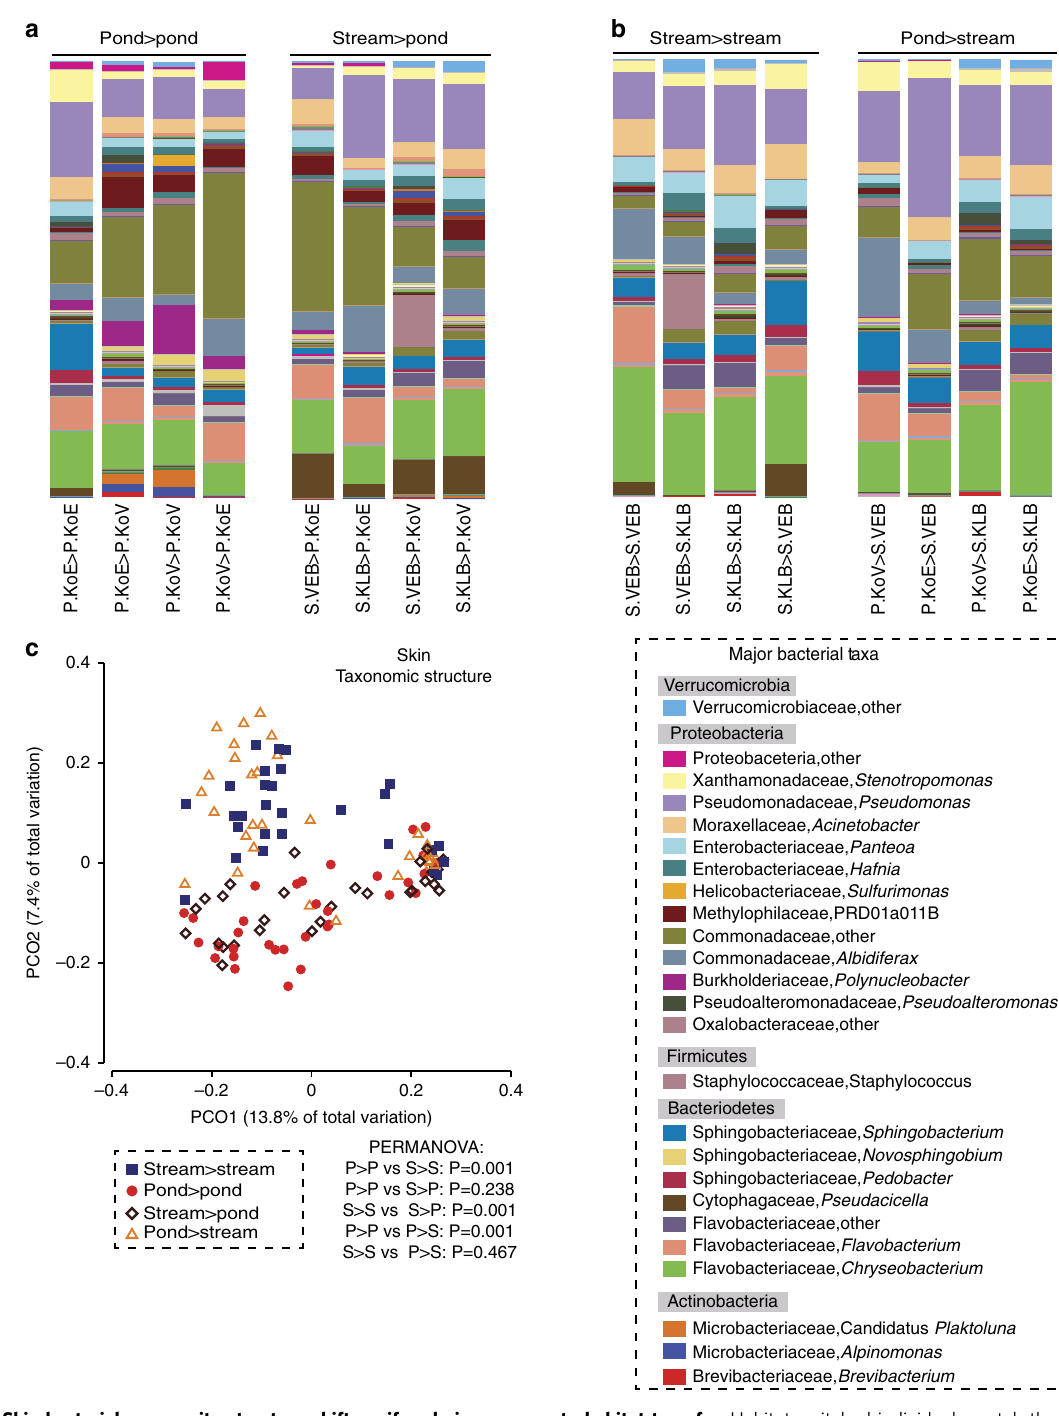
Figure 6 | Skin bacterial community structure shifts uniformly in response to habitat transfer. Habitat-switched individuals match the community structure of destination habitat controls. ( a ) ( b ) show mean relative abundance profiles of Core50 OTUs in the skin bacterial communities of larvae at the genus level. a highlights larvae derived from streams and transferred to ponds. b highlights larvae derived from ponds and transferred to streams. Major bacterial taxa are identified in the provided legend. c shows Principle Coordinate Analysis of unweighted Unifrac distance matrices of the full community for both habitat-switched group in comparison to both habitat-control groups. Sample sizes were: n ¼ 36 (SS; blue squares), n ¼ 38 (PP; red circles), n ¼ 27 (SP; brown open squares), n ¼ 36 (PS; yellow open triangles). Pair-wise PERMANOVA results are displayed below the PCoA. PERMDISP showed no differences in dispersions among groups (F (3,118) ¼ 0.82197, P ¼